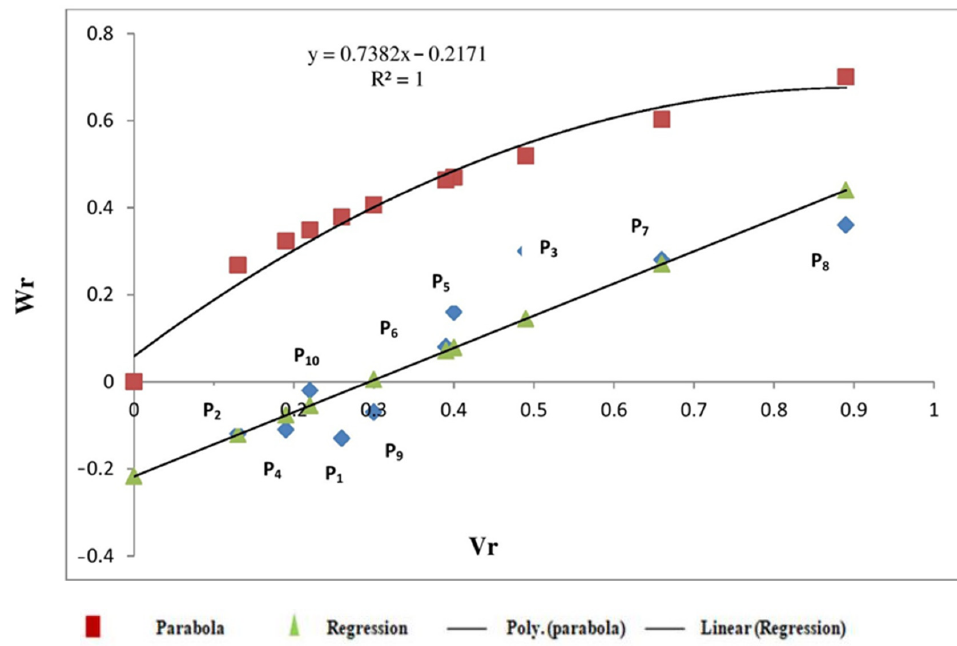
Figure 6. Wr–Vr graph for starch content in E 1 . P1 = GW 451; P2 = GW 496; P3 = LOK 1; P4 = GW 322; P5 = GW 366; P6 = HI 1544; P7 = GW 173; P8 = GW 11; P9 = HD 2864; P10 = UAS 385.